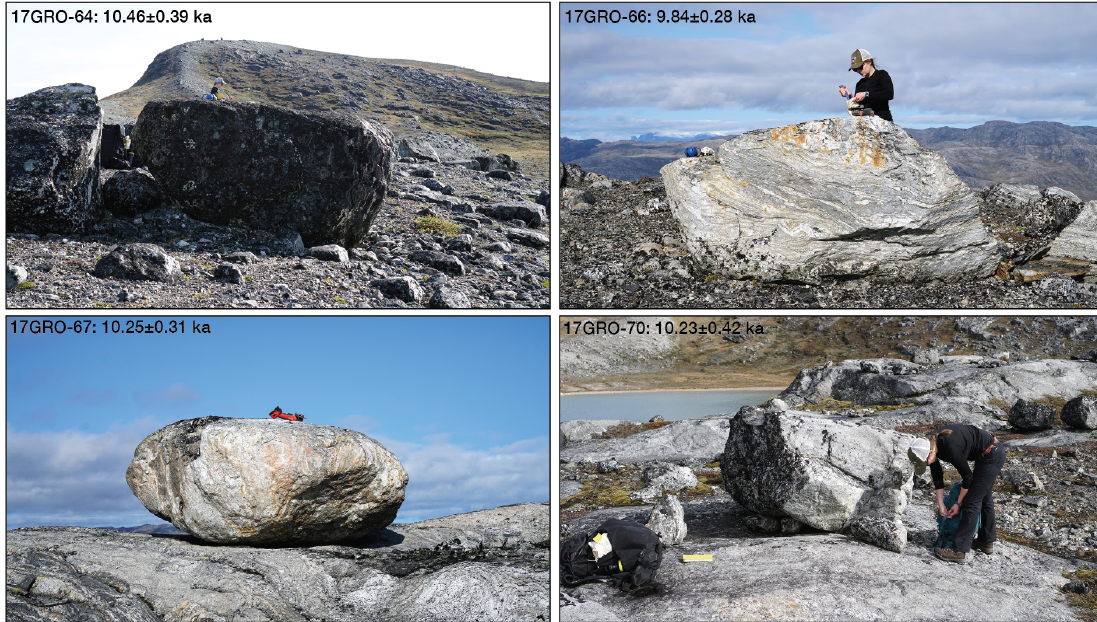
Figure 8. Representative boulder samples related to the Kapisigdlit stade moraine west of KNS. 17GRO-64 and 17GRO-66 are moraine boulders, whereas 17GRO-67 and 17GRO-70 are erratic boulders resting on bedrock located immediately inboard and outboard of the Kapisigdlit stade